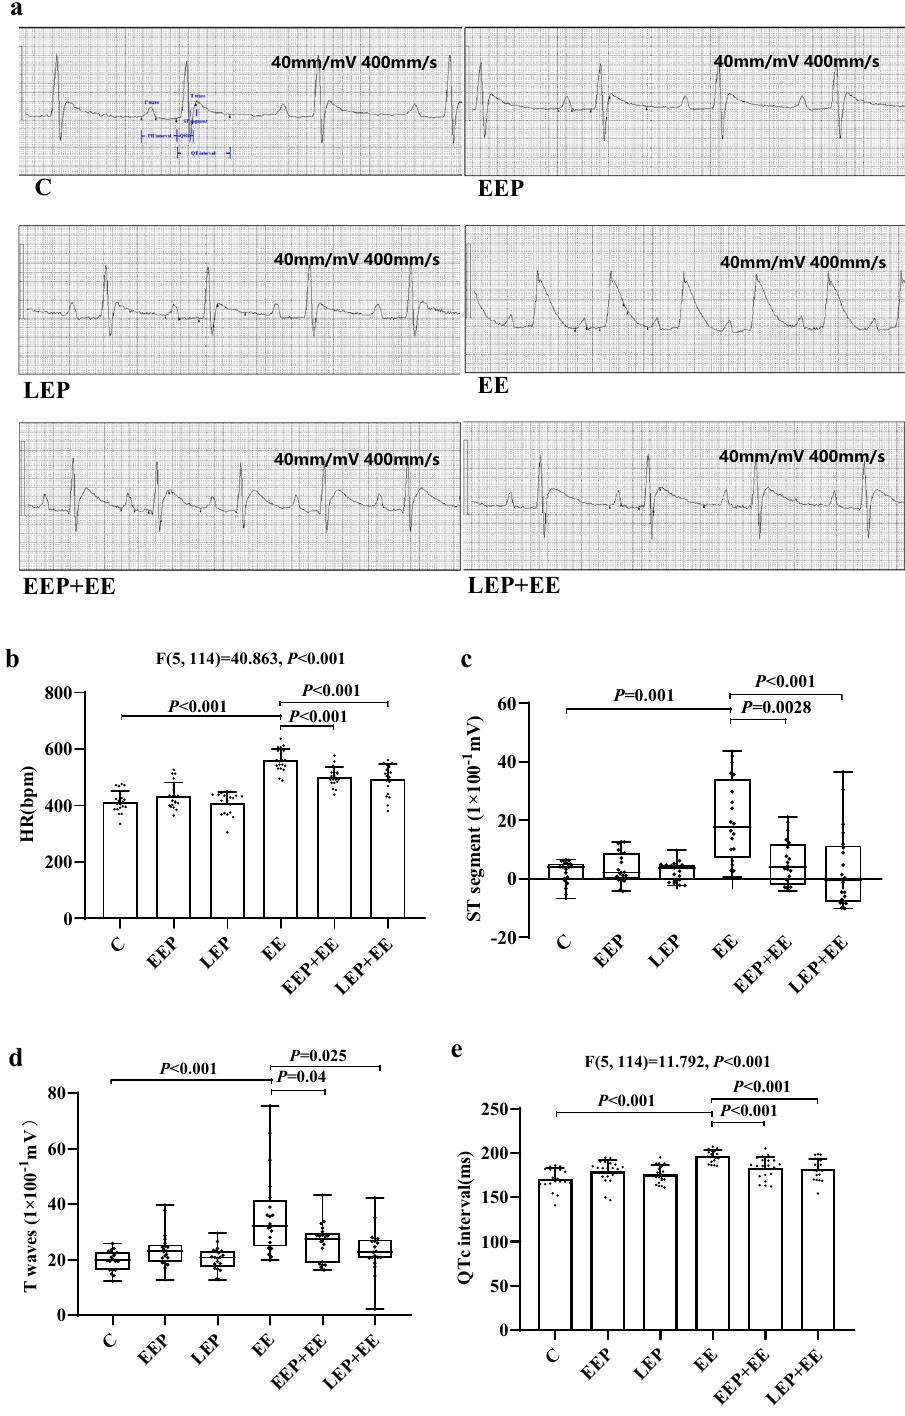
Figure 2. ECG analysis results in rats. ( a ) The ECG waves in rats (40 mm/mV, 400 mm/s). ( b ) HR results in each group of rats (LSD test). ( c ) Changes in ST segments on ECG (K-W test). ( d ) Changes in T waves on ECG (K-W test). ( e ) Changes in QTc intervals on ECG (LSD test). The elevation of the ST segment in group EE was significantly higher than that in group C, and the ST segments of group EEP + EE and group LEP + EE were significantly lower than that of group EE ( a , c ). The T wave of group EE was significantly higher than that of group C; the T waves were significantly lower in group EEP + EE and group LEP + EE than in group EE ( a , d ). The QTc interval in group EE was obviously prolonged compared with that in group C, and the QTc intervals in group EEP + EE and group LEP + EE were obviously shortened compared with that in group EE ( a , e ). Compared with that of rats in group C, the HR of rats in group EE was significantly higher. Compared with that of rats in group EE, the HR of rats in group EEP + EE and group LEP + EE was significantly lower. The results suggested that EP could significantly decreased the HR during exhaustive exercise ( b ). The results suggested that EP could effectively reduce the extent of ischemia/hypoxia induced by exhaustive exercise and that the occurrence of malignant arrhythmia, which was increased by exhaustive exercise, could be improved by